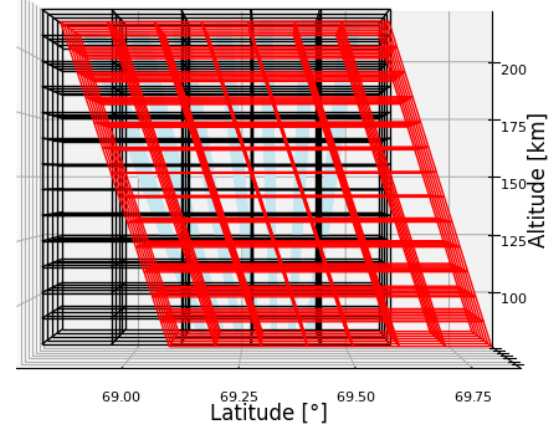
Figure 4. Latitude–height view of experimental layout.